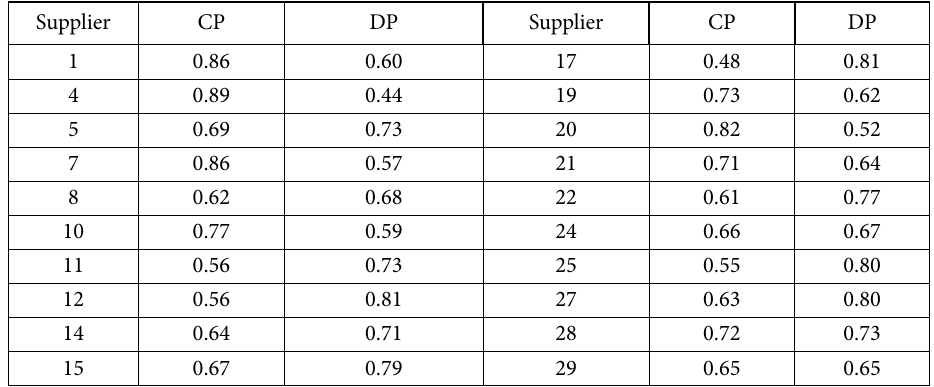
Table 27. Comparative and diversity performance for oil injection